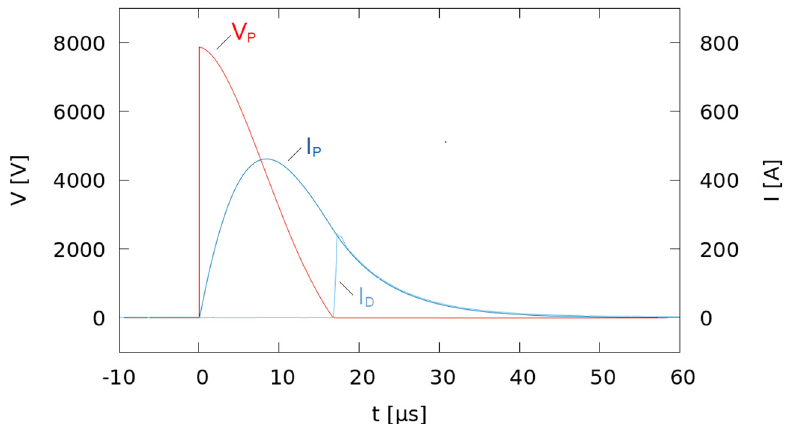
Figure 1. Simulated pulse voltage V P and pulse current I P at the output terminal of an 8-stage Marx generator with free-wheeling diodes. After the discharge of the stage capacitors, the pulse current commutates to the free-wheeling diodes (I D ).